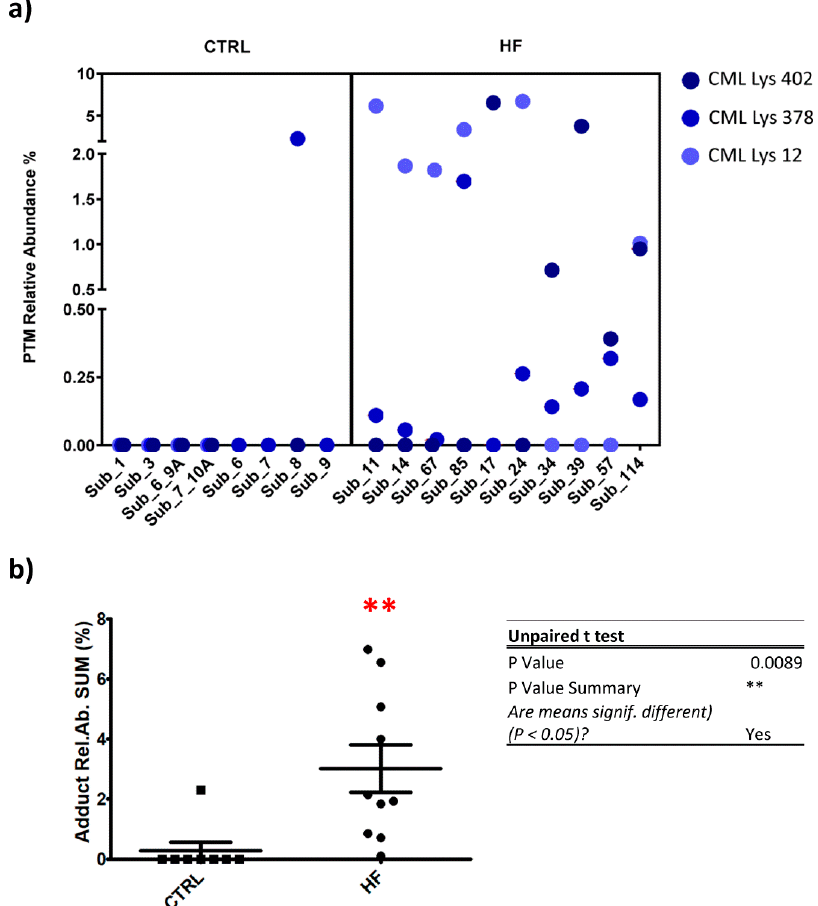
Figure 5. Panel ( a ): Graphical representation of the extent of the most representative AGE/ALE adducts in both CTRL and HF individual subjects. The color code (see legend) serves to distinguish each CML protein adduct. Panel ( b ): Plot showing the distribution of the sum of the CML relative abundances calculated for each subject (CTRL vs. HF); the difference between the two groups was proven to be significant by means of an unpaired t -test ( p < 0.01). (** p -value summary). As above outlined, the targeted approach was set to search for not only those adducts showing a uniqueness in HF samples, but also those detected, albeit to a lesser extent, in CTRL